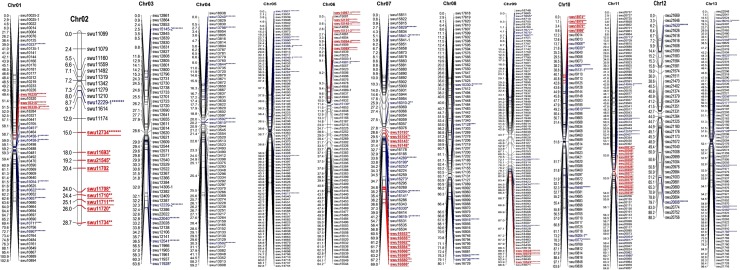
Genetic maps for the 13 chromosomes of the F2interspecific individuals derived between G. thurberi and G. trilobum.The markers in blue are distorted while markers in red and underlined indicates the distorted regions per chromosomes.